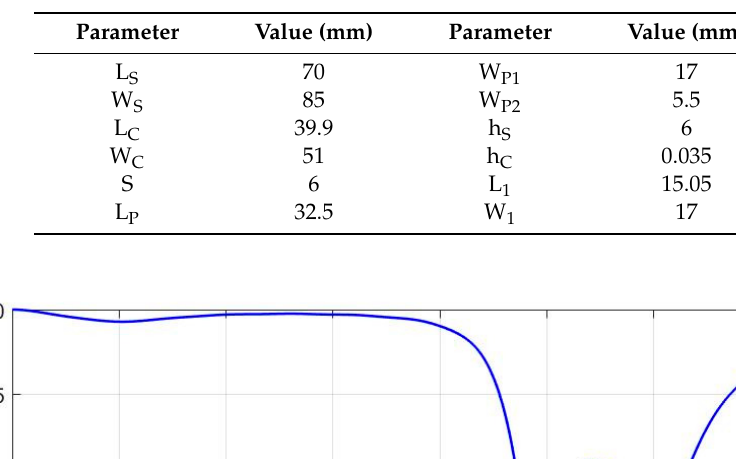
Table 1. Antenna design parameters.